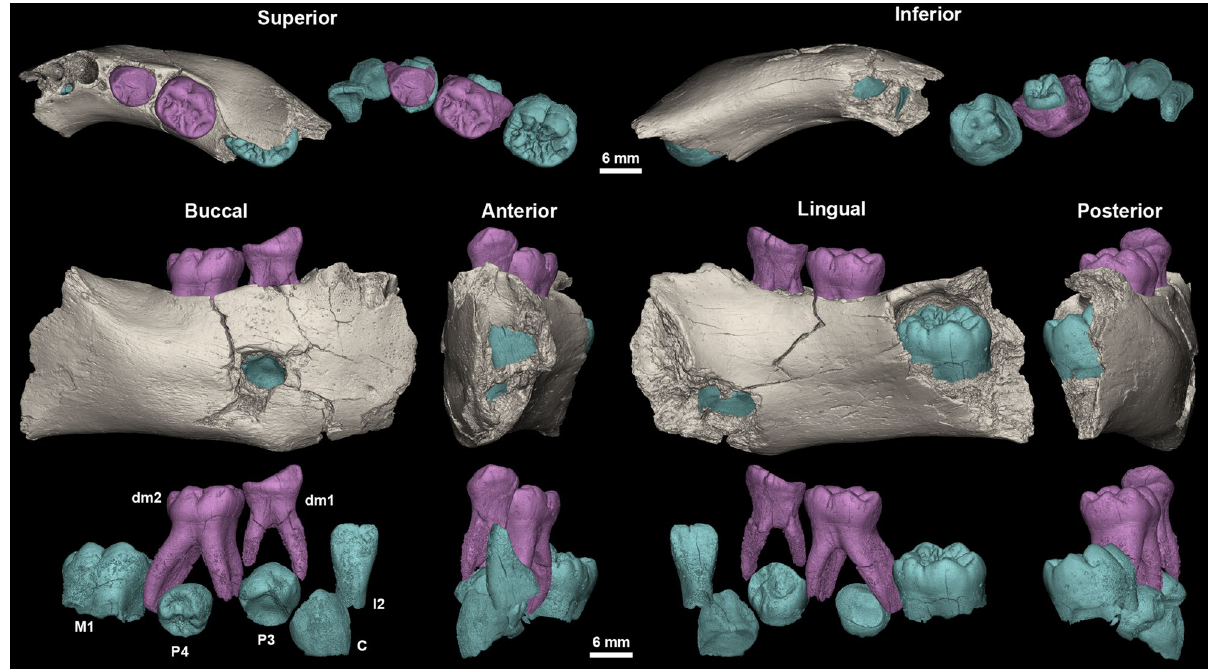
Figure 2. 3D models of the GAR IVE right hemi-mandible showing the mandibular bone (beige), the preserved deciduous molars (dm1 and dm2; pink) and the germs of the permanent teeth (I2: lateral incisor, C: canine, P3 and P4: first and second premolar, M1: first molar; blue). Superior, inferior, buccal, anterior, lingual and posterior views.